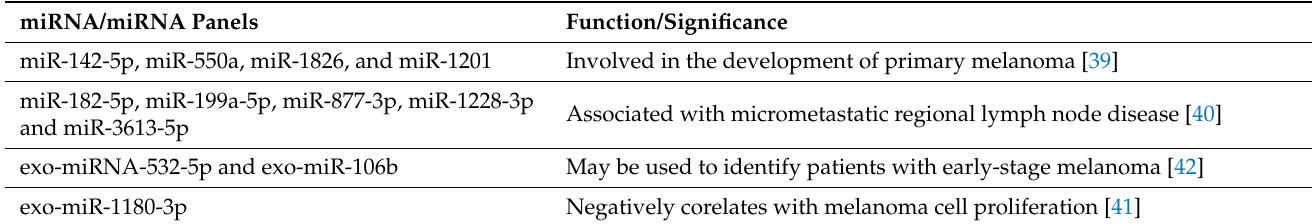
Table 1. Cont. miRNA/miRNA Panels